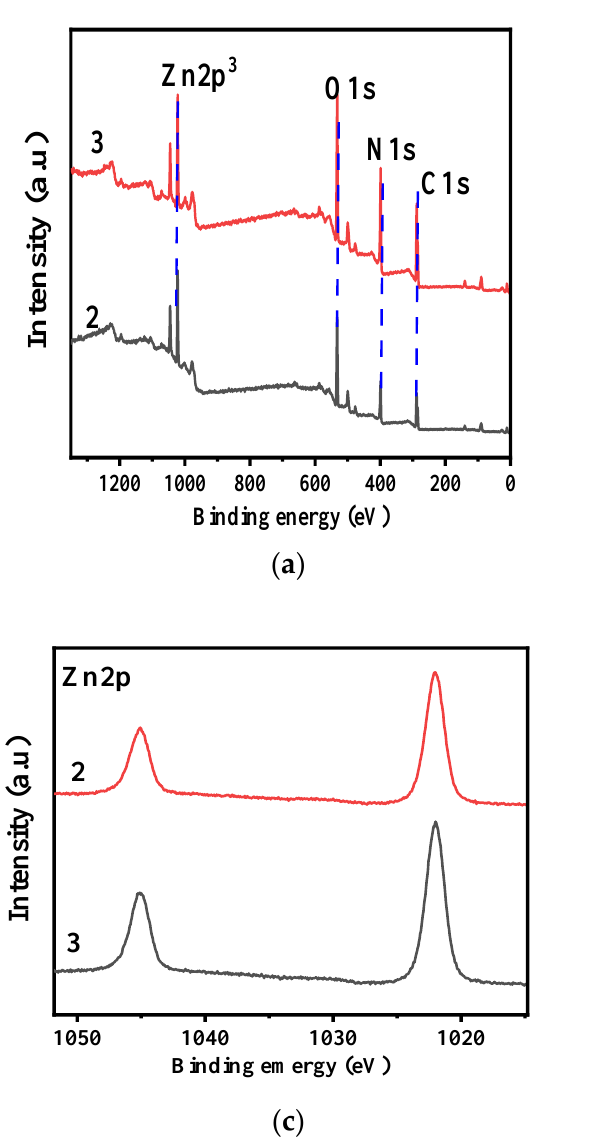
Figure 1. Survey XPS spectra of C 3 N 4 /ZnO, ( a ) and high resolution XPS spectra of ( b ) O 1s ( c ) Zn 2p ( d ) N 1s.